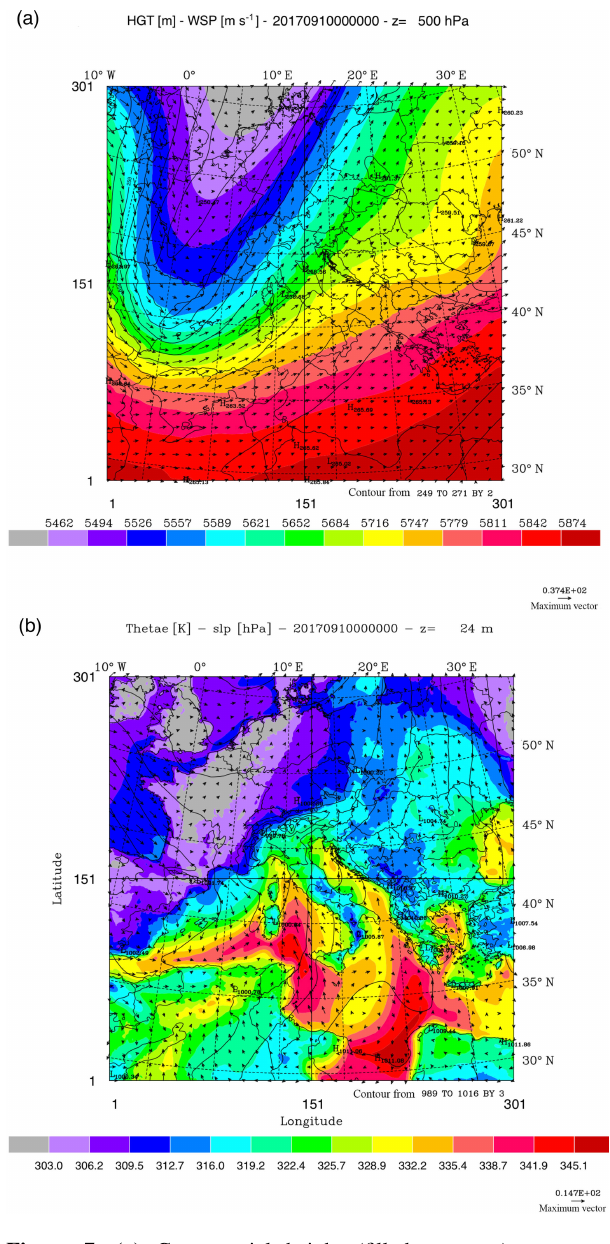
Figure 7. (a) Geopotential height (filled contours), tempera- ture (contours), and wind vectors at 500hPa at 00:00UTC on 10 September 2017. Maximum velocity is 37ms − 1 ; (b) equiva- lent potential temperature (filled contours), sea-level pressure (con- tours), and wind vectors at 24m above the surface (maximum value 15ms − 1